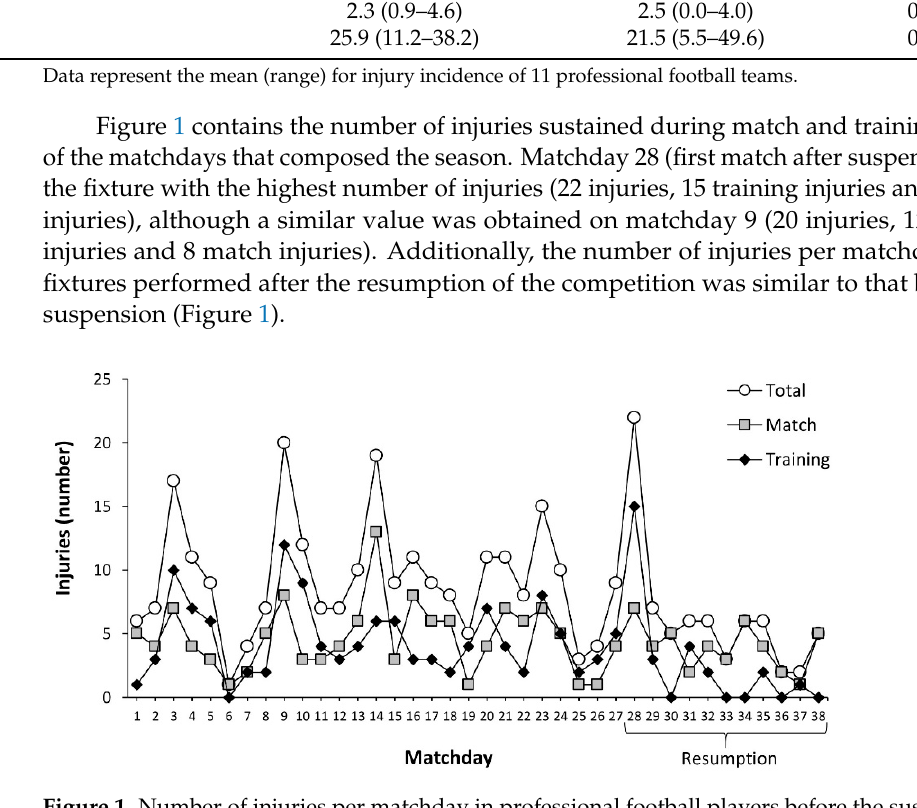
Data represent the mean (range) for injury incidence of 11 professional football teams.